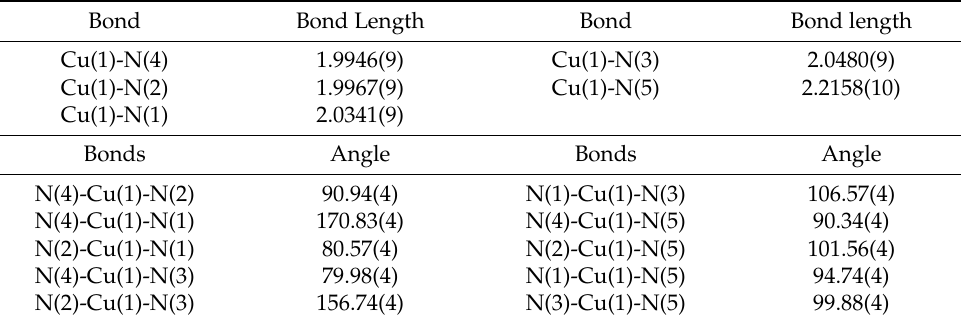
Figure 5. X-ray structure of 2 drawn at 50% probability level for thermal ellipsoids. The labels of the protons, except split H1 and H2 atoms are not depicted for better clarity. Table 4. Bond lengths (Å) and angles ( ◦ ) for complex 2